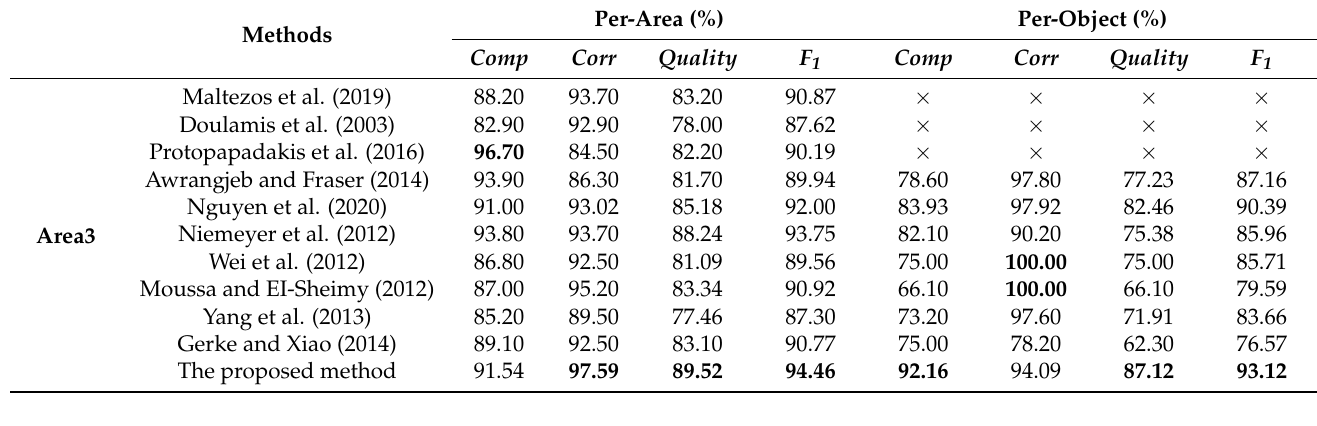
Table 3. Accuracy comparison of building extraction in Area3. The experimental results of the ten methods are obtained from the corresponding references. Bold font represents the highest value among the comparison results. “ × ” denotes that the results are not provided by the reference. Note that the methods proposed by Maltezos et al. (2019), Doulamis et al. (2003) and Protopapadakis et al. (2016) do not provide the completeness, correctness and quality at per-object level.